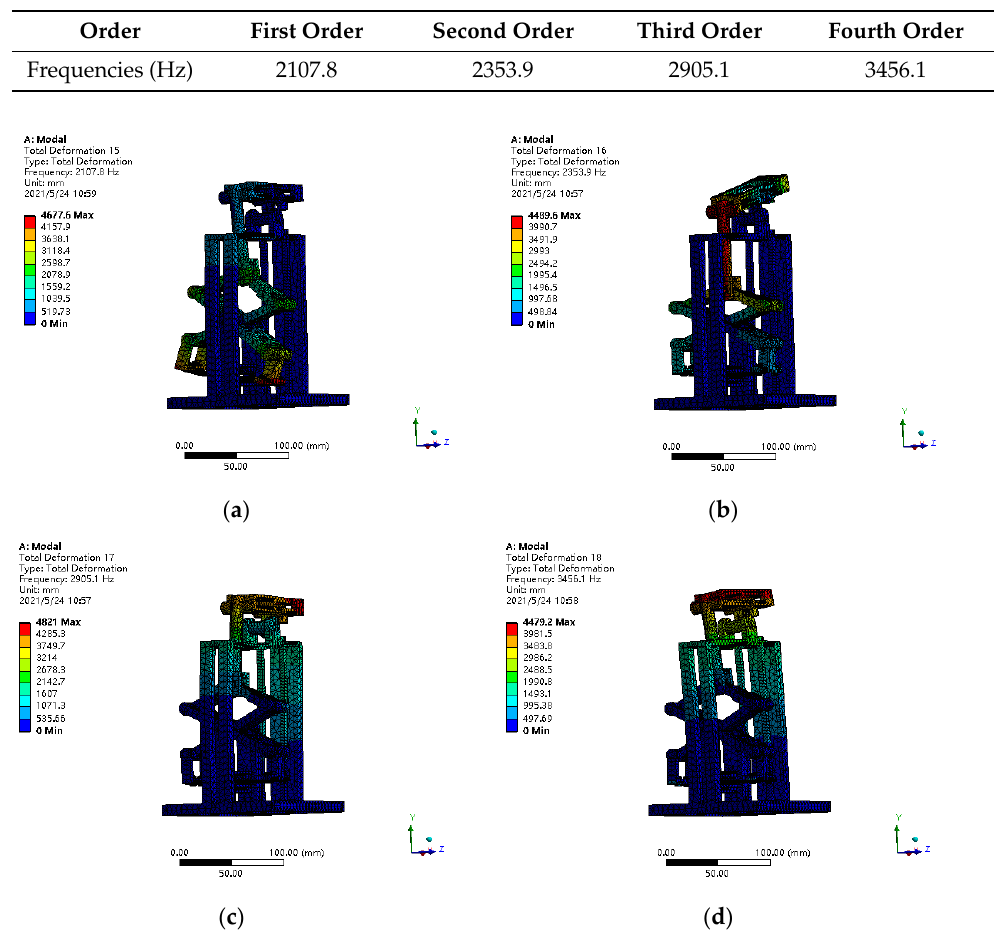
Figure 8. Modal shapes of piezoelectric generator. ( a ) First-order modal shape; ( b ) second-order modal shape; ( c ) third-order modal shape; ( d ) fourth-order modal shape. Table 3. Natural frequencies of the piezoelectric